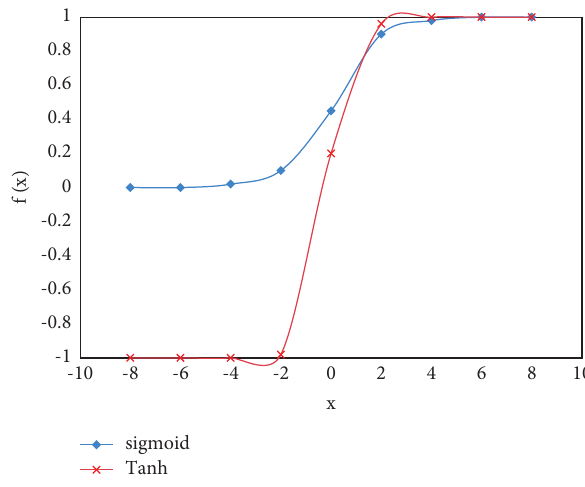
Figure 4: Sigmoid and tanh function